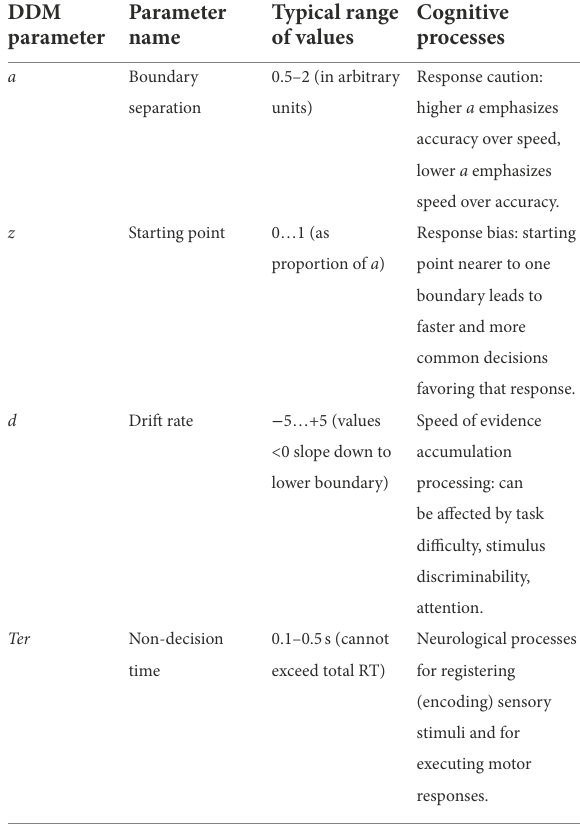
TABLE 1 Free parameters in a “standard” drift diffusion model (DDM), and associated latent cognitive processes. DDM Parameter parameter